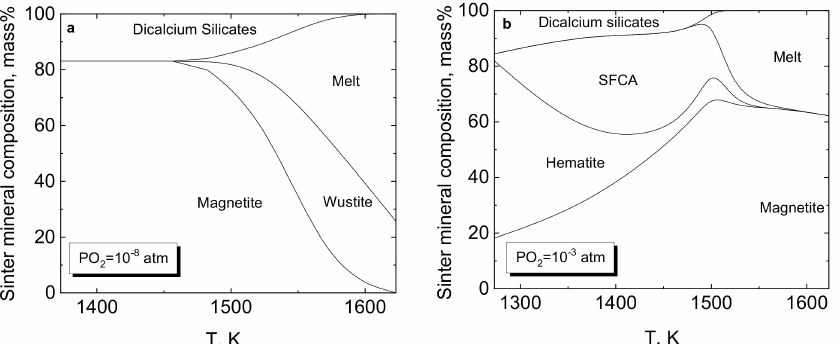
Figure 6. Phase composition of sinter under varied temperature at oxygen partial pressure of ( a ) 10 − 8 atm and ( b ) 10 − 3